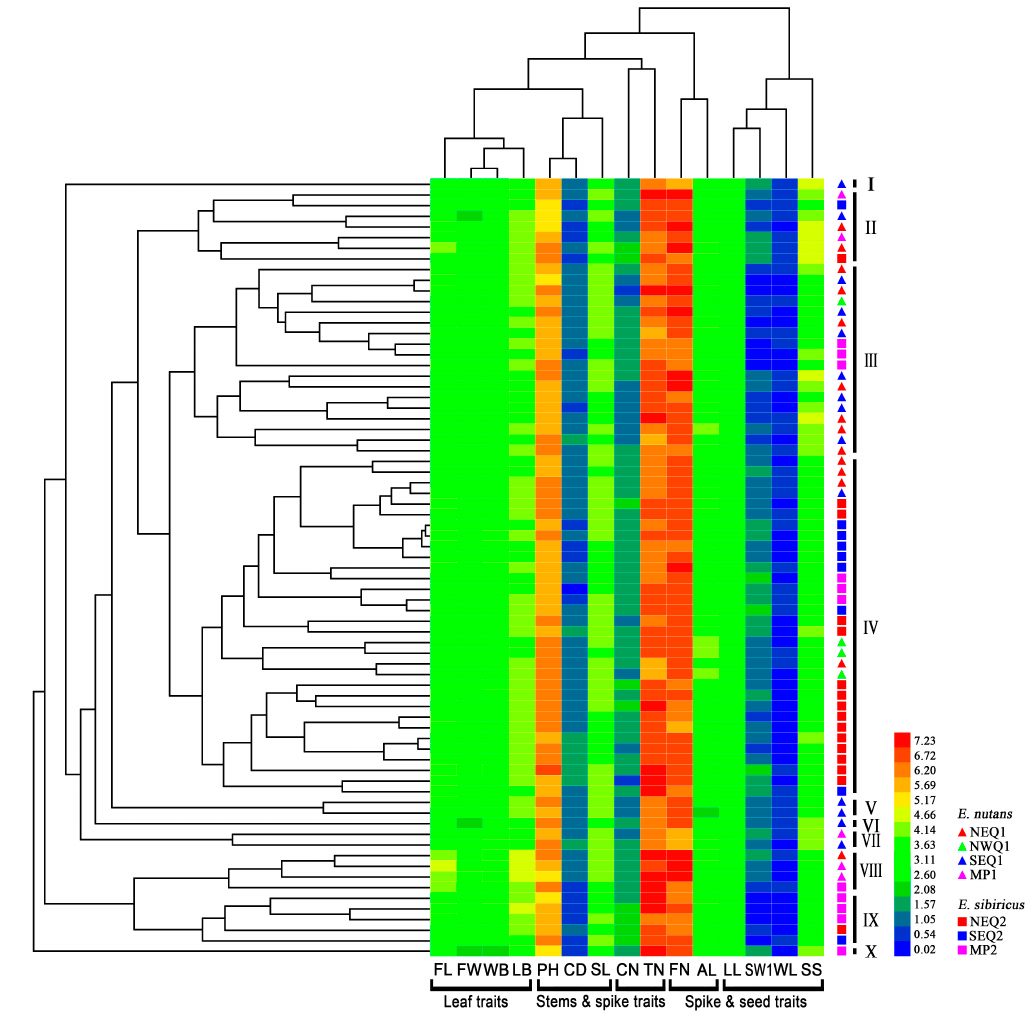
Figure 1. Clustering and Heatmap analysis of the 73 Elymus accessions using fifteen phenotypic traits. All of the 73 Elymus accessions were clustered in ten subgroups. Each line and column represents different accessions and different traits, respectively.